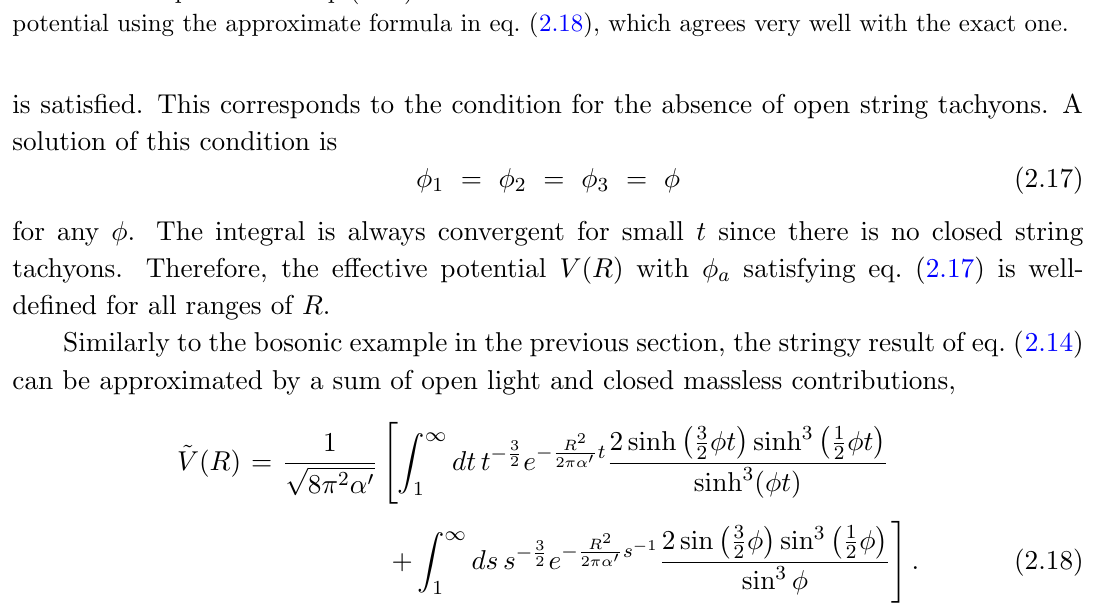
Figure 1 . The e(cid:11)ective potential V ( R ) for D3-branes at angle with (cid:30) = (cid:25)= 12 and (cid:11) 0 = 1. The exact e(cid:11)ective potential in eq. (2.14) is drawn with red solid line. The blue broken line shows